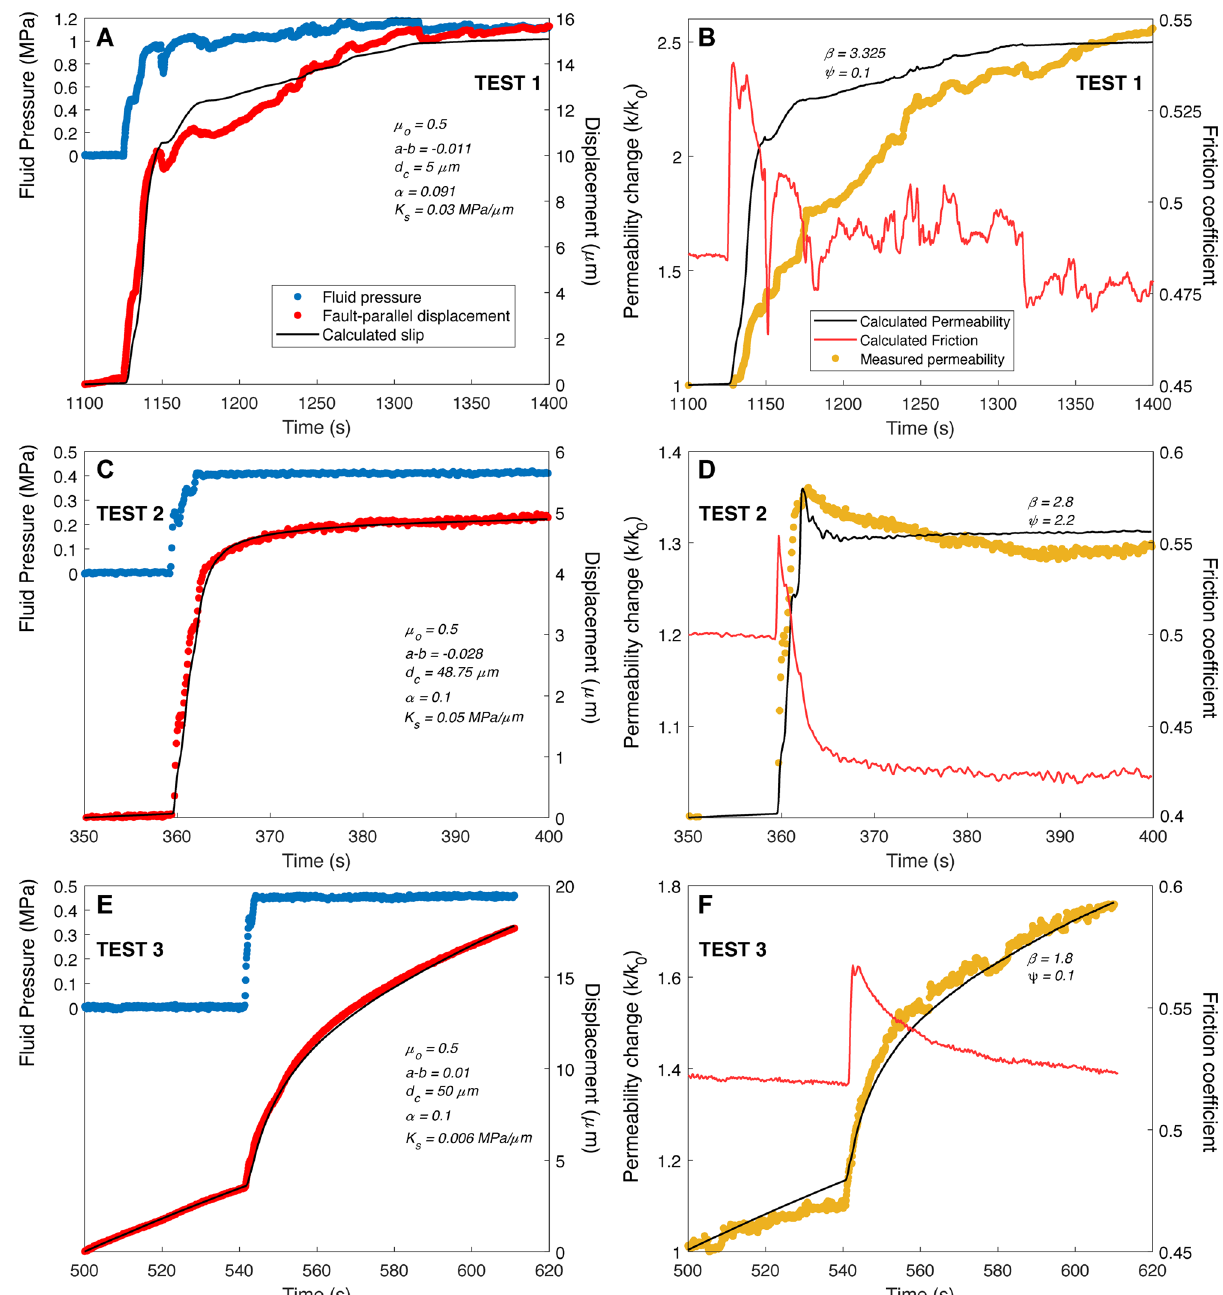
Fig. 4 Transient evolution of fault slip, permeability and friction during a fast-step increase in fl uid pressure. Best- fi t model solutions to experimental data and associated change in friction and permeability for ( A – B ) Test 1, ( C – D ) Test 2, ( E – F ) Test 3. Frictional parameters a, b, d c , μ 0 , K s and α were estimated using Eqs. (3), (4), (5), and parameters β , γ , and ψ for permeability change using Eqs. (1), (2), (6) and